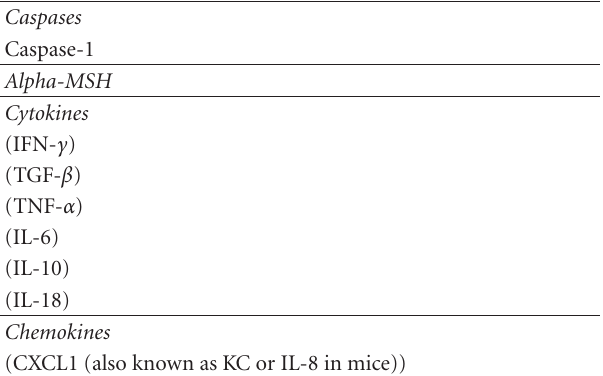
Table 1: Inflammatory mediators of